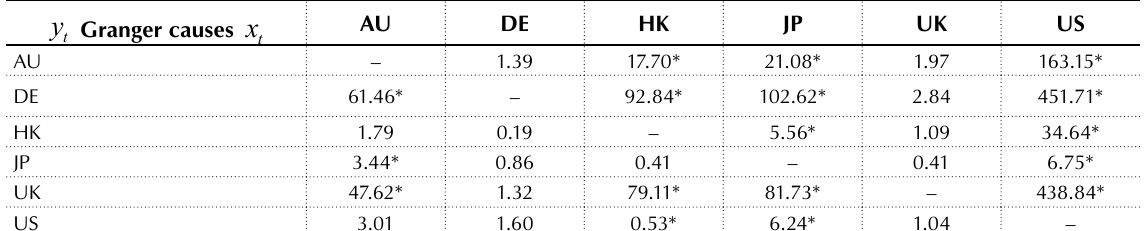
Table 5. Granger causality test for returns, crisis sub-period